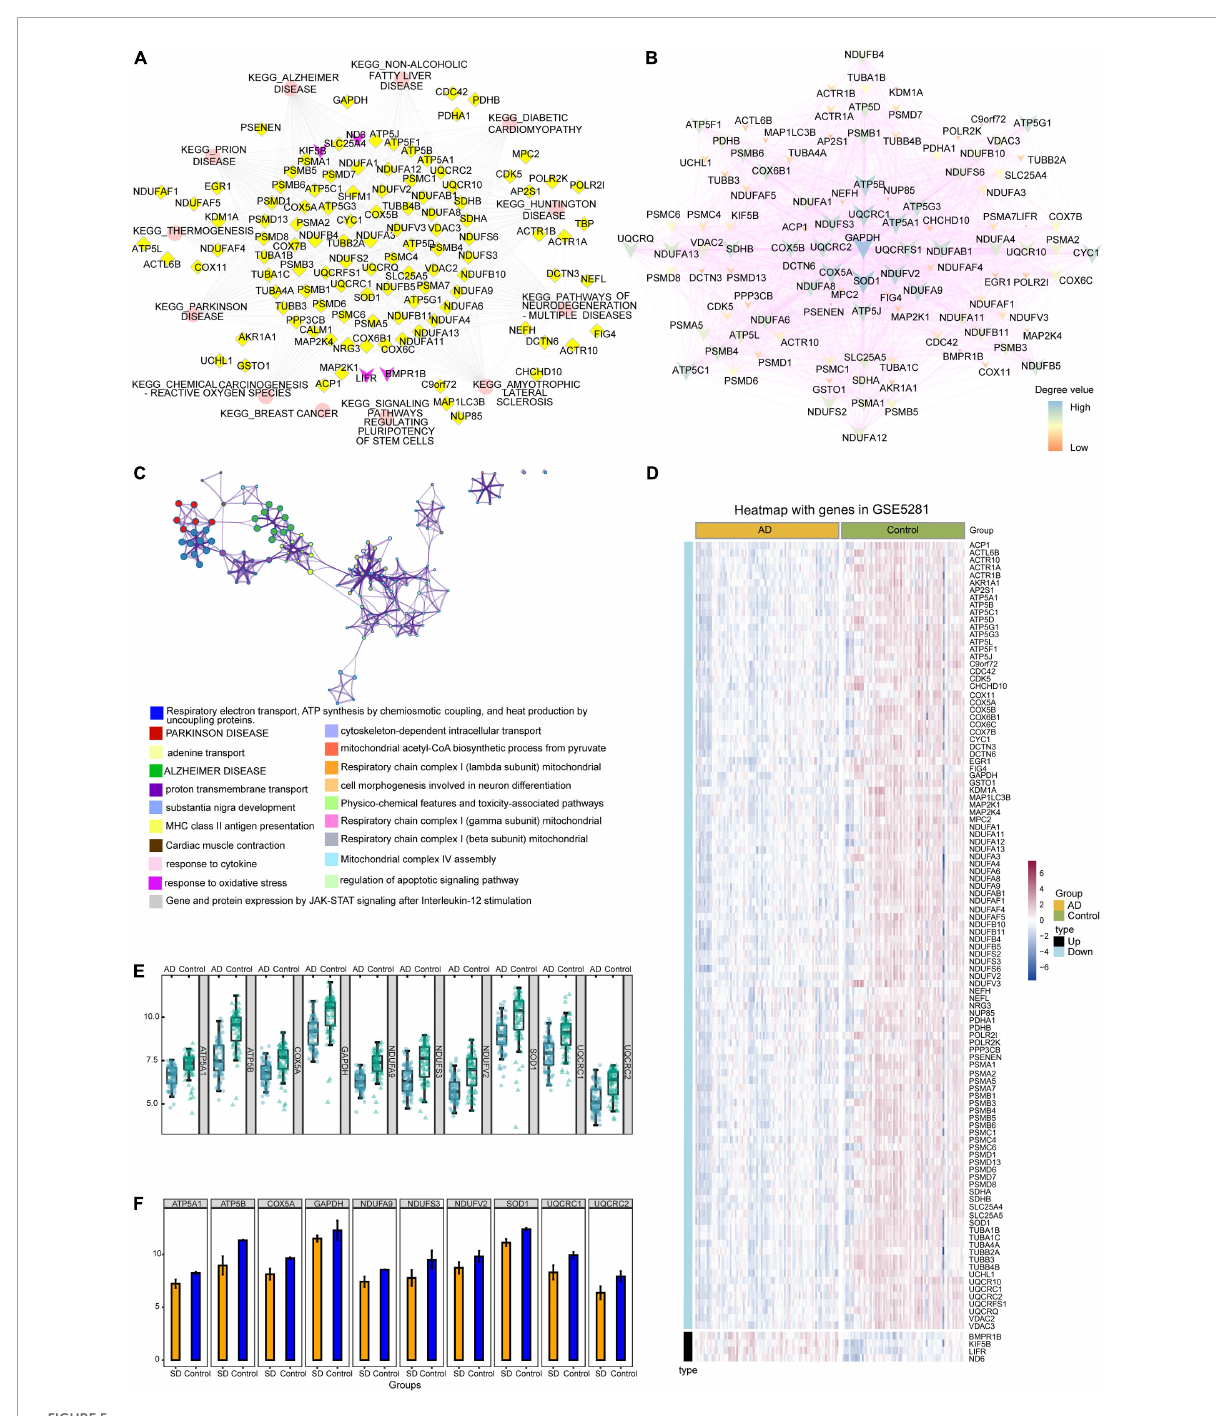
FIGURE5 Protein-protein interaction (PPI) network and expression analysis. (A) Interaction of the 12 common pathways and common genes analyzed by Cytoscape. Red ellipses indicate pathways; yellow diamonds, downregulated genes; purple V-symbols, upregulated genes. (B) Interaction of common genes in the PPI network. Low-degree values are indicated by the small nodes and bright color, while high-degree values are indicated by larger nodes and dark color. (C) Functional enrichment analysis showed that common genes were involved mainly in Parkinson’s disease and Alzheimer’s disease (AD). (D) Heat map showing the expression of common genes in the GSE5281 dataset. (E) Box diagram showing degrees of connectivity of the top 10 genes in AD and controls. (F) Bar plot showing the degree values of the top 10 genes in sleep disorder and control group. SD, sleep